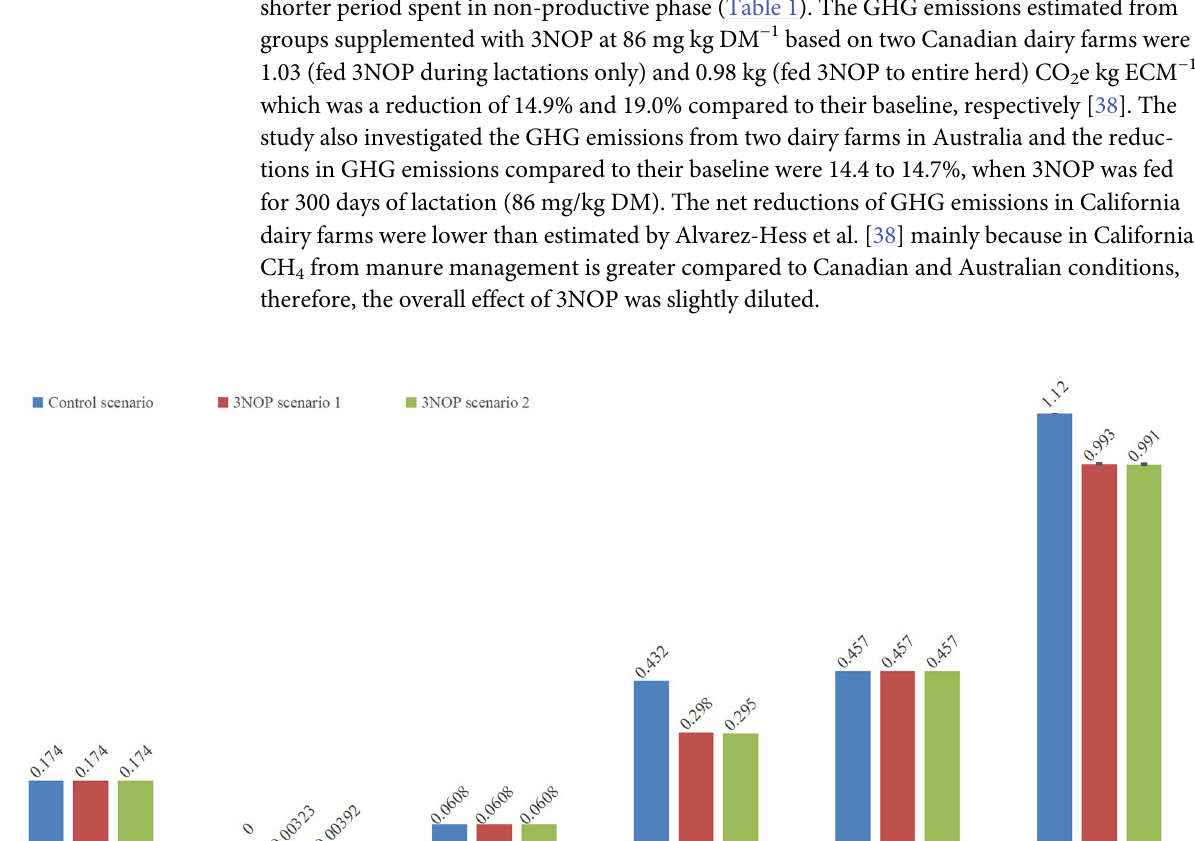
PLOS ONE | https://doi.org/10.1371/journal.pone.0234289 September 18,